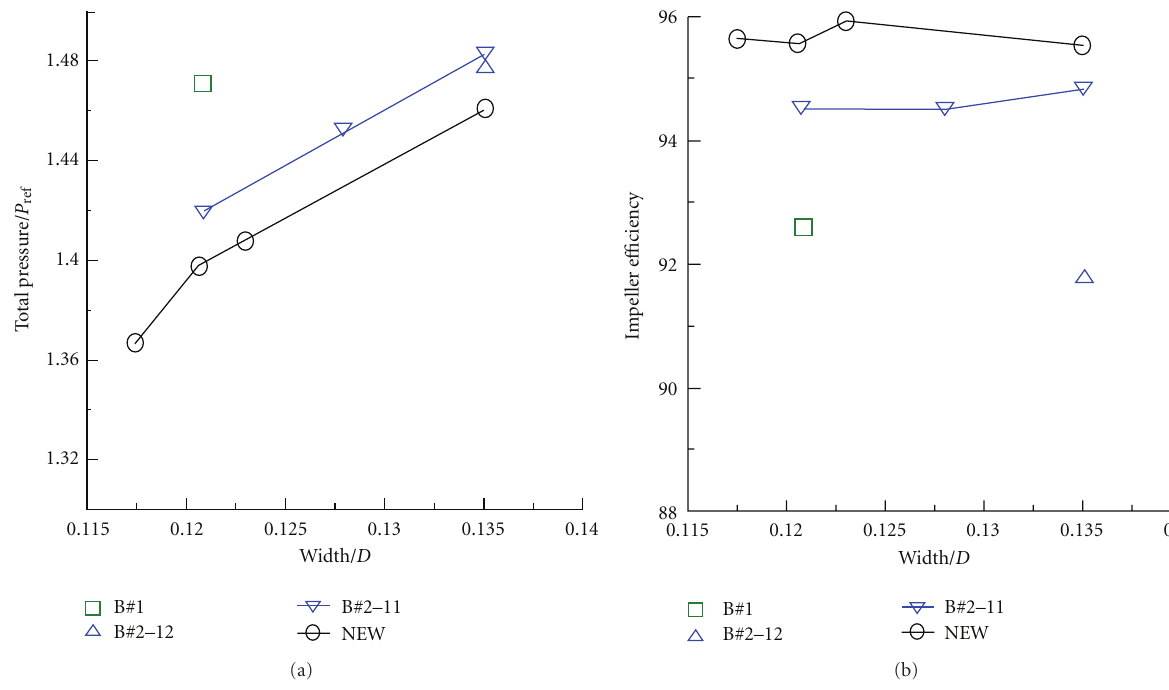
Figure 16: E ff ects on performance from changing the impeller width.